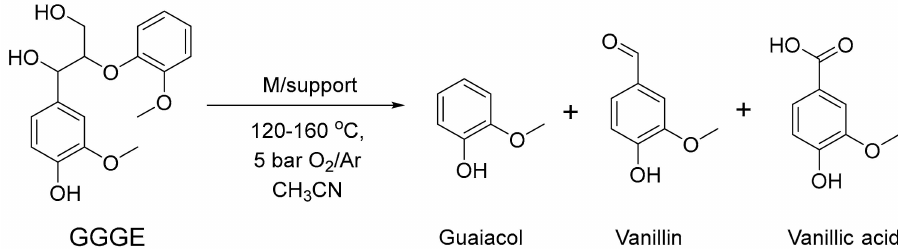
Table 1. Catalytic oxidation of guaiacyl glycerol- β -guaiacyl ether (GGGE) over di ff erent metal / alumina catalysts a . Entry Catalyst BET Surface